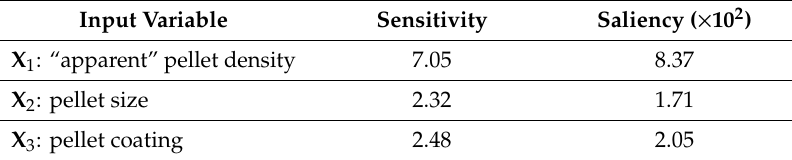
Table 5. ANN—Causal importance (sensitivity) and predictive importance (saliency) of the examined input variables.